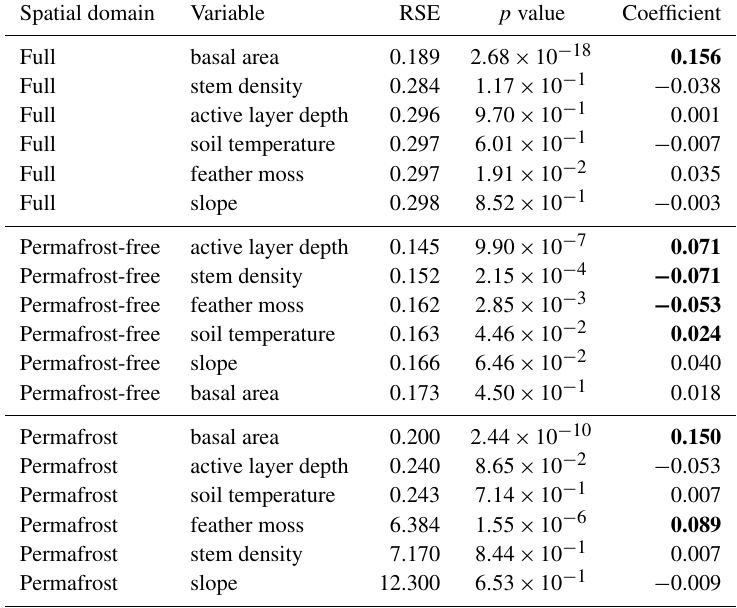
Table 3. Generalized least squares model fits for Fall soil respiration. All details as in Table 2.